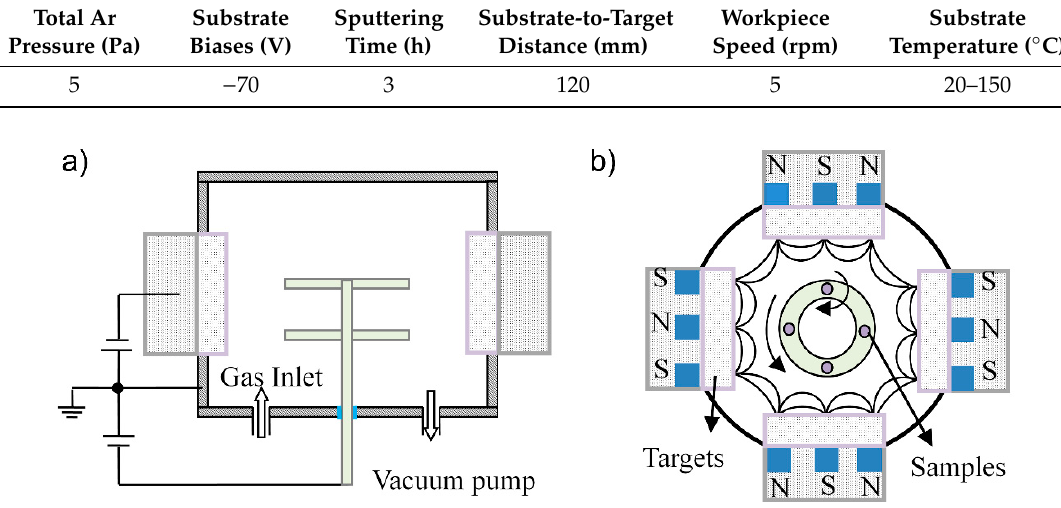
Table 2. The constant parameters for the magnetron sputtering process.